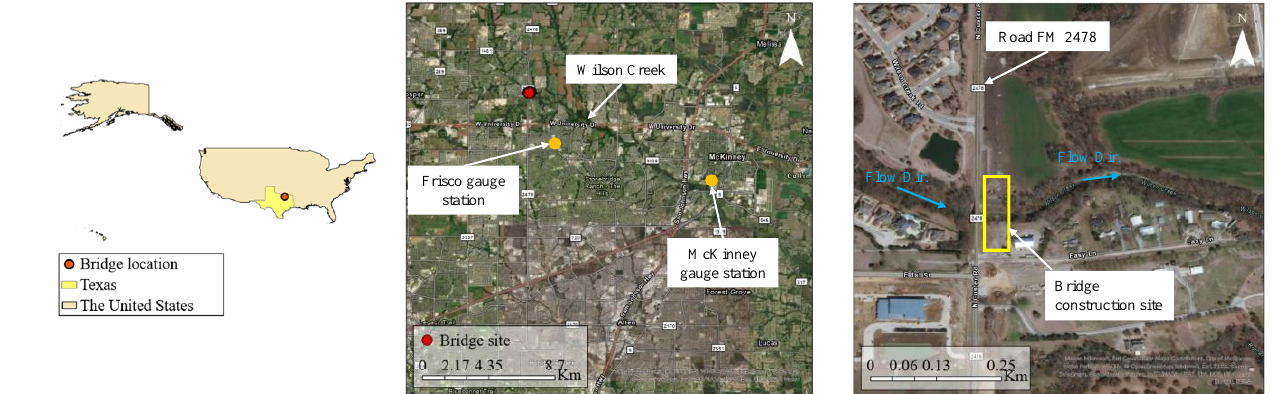
Figure 6. Wilson Creek bridge construction site on highway FM 2478, McKinney, Texas, U.S. and nearby precipitation and discharge gauge stations.